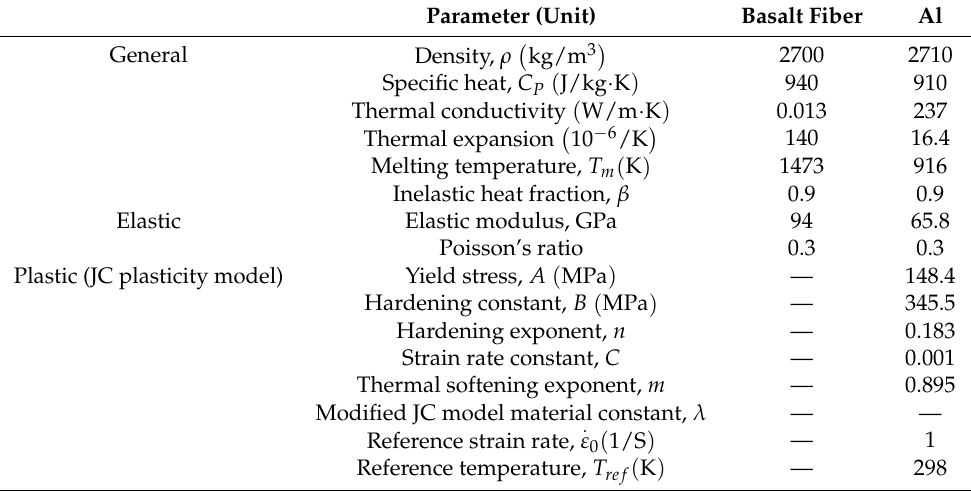
Table 1. Material